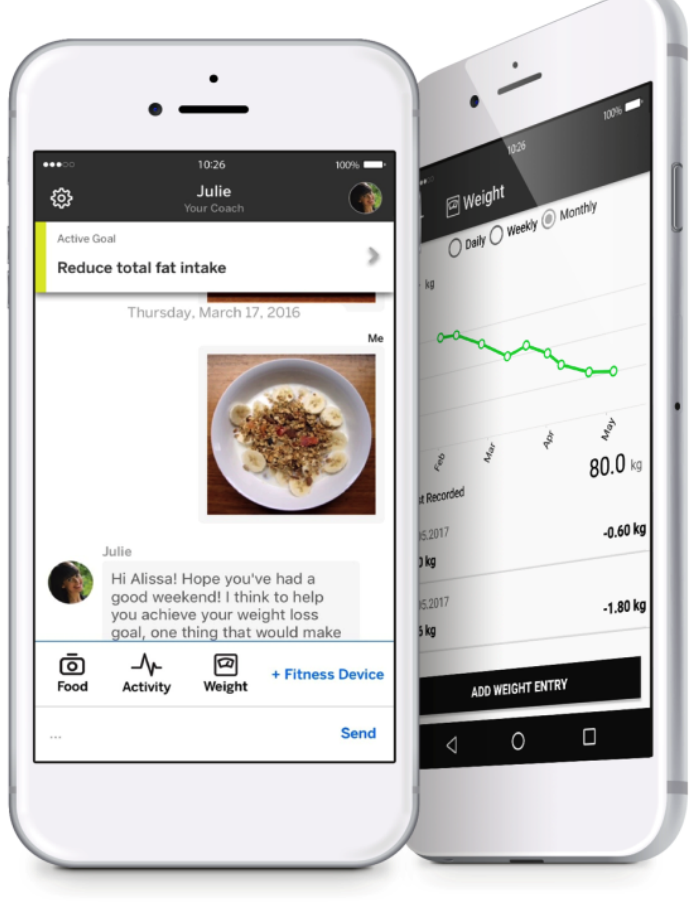
Figure 1. Client view of a chat communication including a photo-based food log and weight